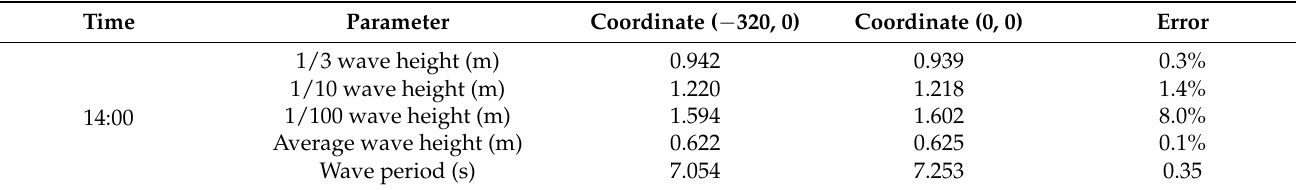
Table 7. Data comparison for different measured coordinates.